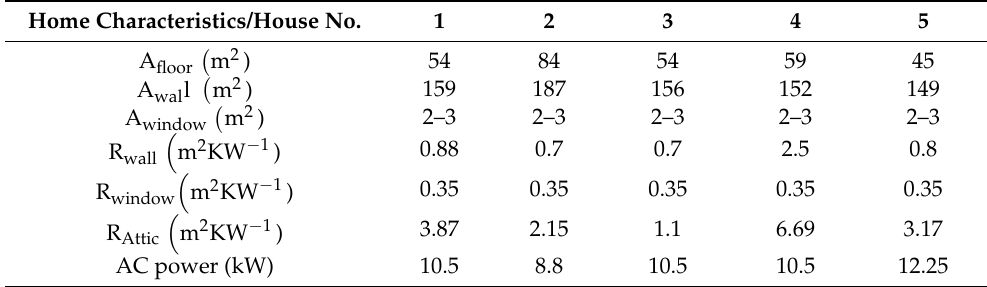
Table 1. Residential building geometrical and energy characteristics data. Home Characteristics/House